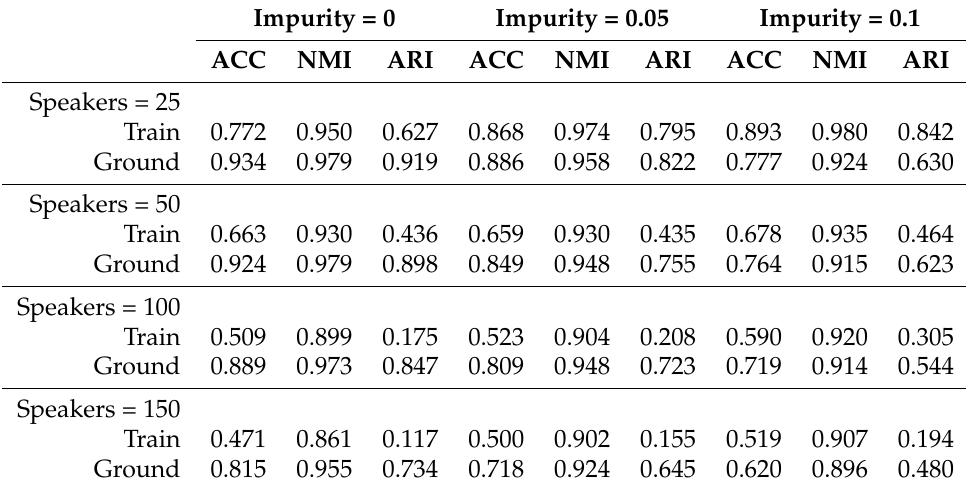
Table 3. The table benchmarks the pairwise architecture in TIMIT dataset with four groups of speakers, 25, 50, 100, and 150. For each group of speakers, the table also considers three segmen- tation impurities, 0, 0.05, and 0.1 to illustrate the shortcomings of incorrect segmentation, for fully unsupervised speaker recognition strategy.